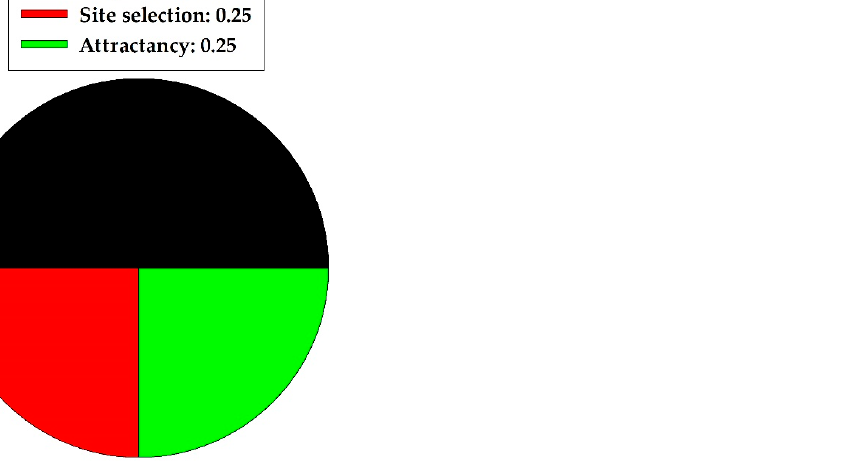
Figure 3. Proportion of specific nonharmful effects of quercetin on natural enemies in two insect orders combined.